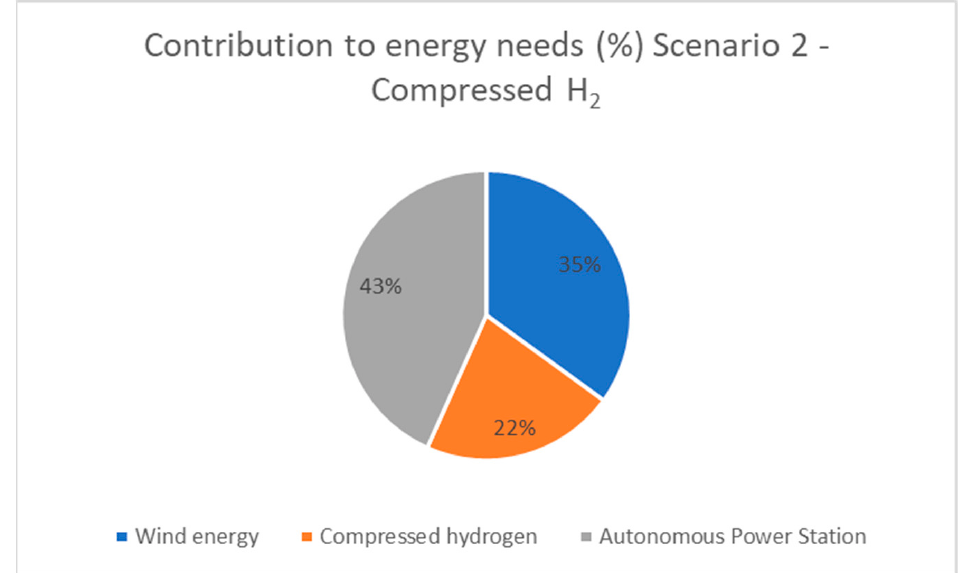
Figure 13. Contribution to energy needs per source using liquefied H 2 .